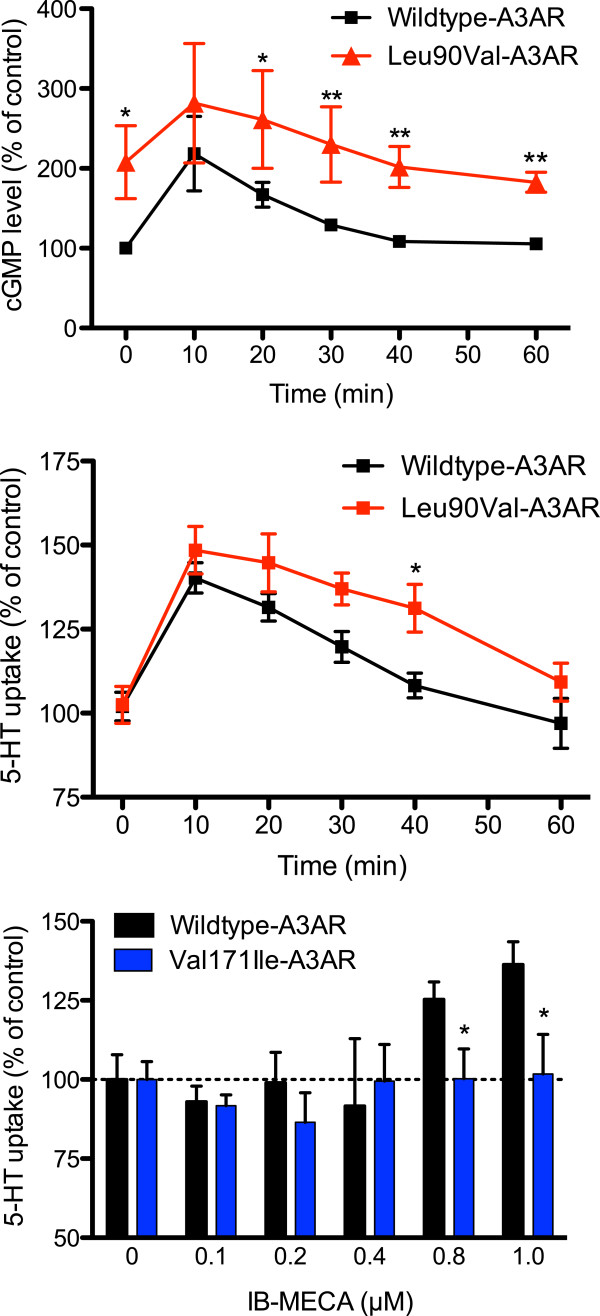
Functional consequences of the A3AR specific agonist IB-MECA on WT-A3AR and Leu90Val-A3AR or Val171Ile-A3AR expressing cells. CHO cells co-transfected with either WT-A3AR or Leu90Val-A3AR or Val171Ile-A3AR and SERT and were stimulated using IB-MECA (1 μM). (A) Levels of cGMP production from WT-A3AR/SERT and Leu90Val-A3AR/SERT co-transfections were measured prior to and after IB-MECA stimulation. Leu90Val-A3AR/SERT cells display elevated basal cGMP production that persists over the entire 60 min time course experiment, revealing enhanced overall production of cGMP (1 tailed t-test P=0.049; n=3). Each of the three independent experiments contained a minimum of three internal replicates. (B) 60 min time-course of IB-MECA induced 5-HT uptake as measured as percent of control (wildtype; time = 0 min). CHO cells were co-transfected with either wildtype-A3AR and SERT or Leu90Val-A3AR and SERT, and 5-HT uptake was stimulated using IB-MECA (1 μM). Cells were incubated with [3H]5-HT (20 nM) for the indicated period. Over the time course (0-60 min) in Leu90Val-A3AR/SERT expressing cells, 5-HT uptake is elevated compared with the wildtype A3AR counterpart (1 tailed t-test, P=0.039; n=4). Each independent experiment contained a minimum of three internal replicates. (C) [3H]5-HT accumulation in cells co-transfected with A3AR and human SERT was measured, and indicate a failure of IB-MECA treatment of Val171Ile-A3AR/SERT to induce SERT dependent 5-HT re-uptake across all tested concentrations. Compared to the peak concentrations (0.8 μM and 1.0 μM) of IB-MECA induced 5-HT uptake in WT-A3AR/SERT, IBMECA induced 5-HT uptake was significantly reduced (for example, 1 μM IB-MECA Val171Ile: 101.8% ± 12.5 vs. WT: 136.3% ± 7.2; two-way ANOVA P=0.005; n=3-4). Significant (P <0.05) findings are indicated by an asterisk (*).